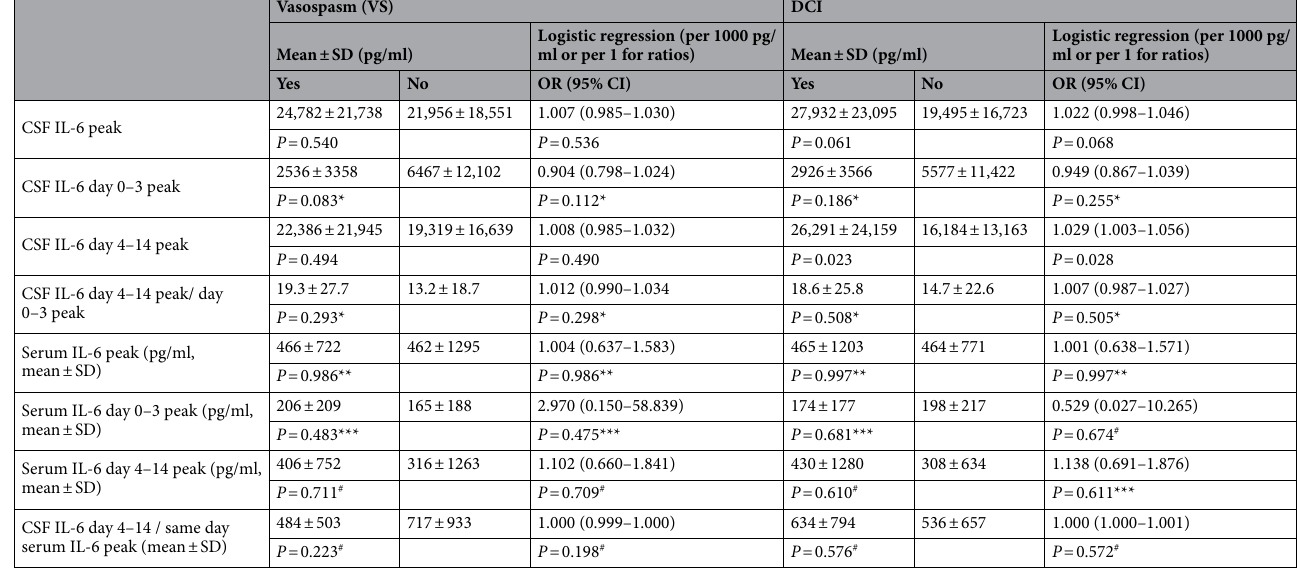
Table 2. Individual interleukin-6 peak levels in correlation with Vasospasm and DCI. *, **, ***, # : N = 71,